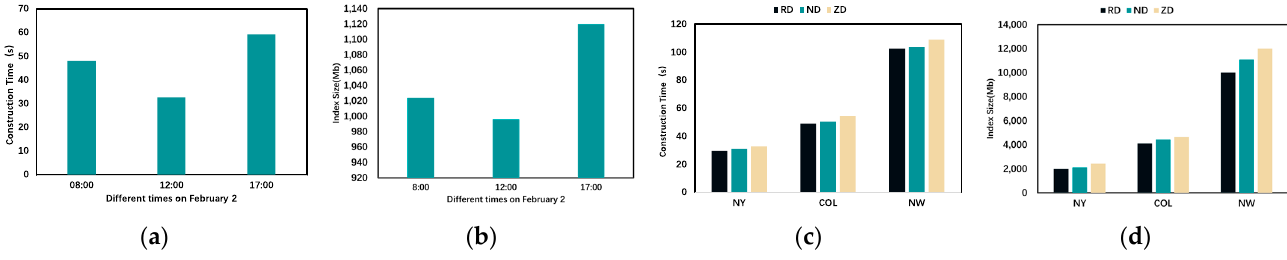
Figure 8. Time and space costs of the DVTG-Index. ( a ) Time costs on BJ; ( b ) Space costs on BJ; ( c ) Time costs on NY, COL and NW; ( d ) Space costs on NY, COL and NW. ( c ) Time costs on NY, COL and NW; ( d ) Space costs on NY, COL and